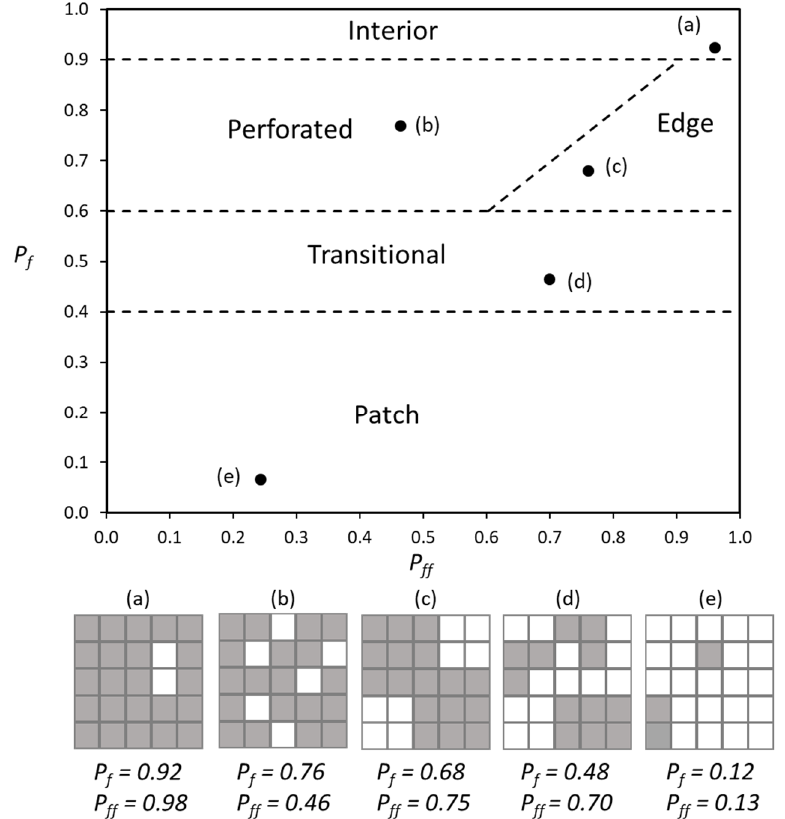
Figure 2. Illustration for the calculations of P f and P ff for various fragmentation categories in a moving window of 5 × 5 pixels. Grassland: grey pixels; no-grassland: white pixels; dashed line: the classification bounds for the various categories of grasslands (adapted from Riitter et al., 2000 [45] and Frate et al., 2015 [49]).